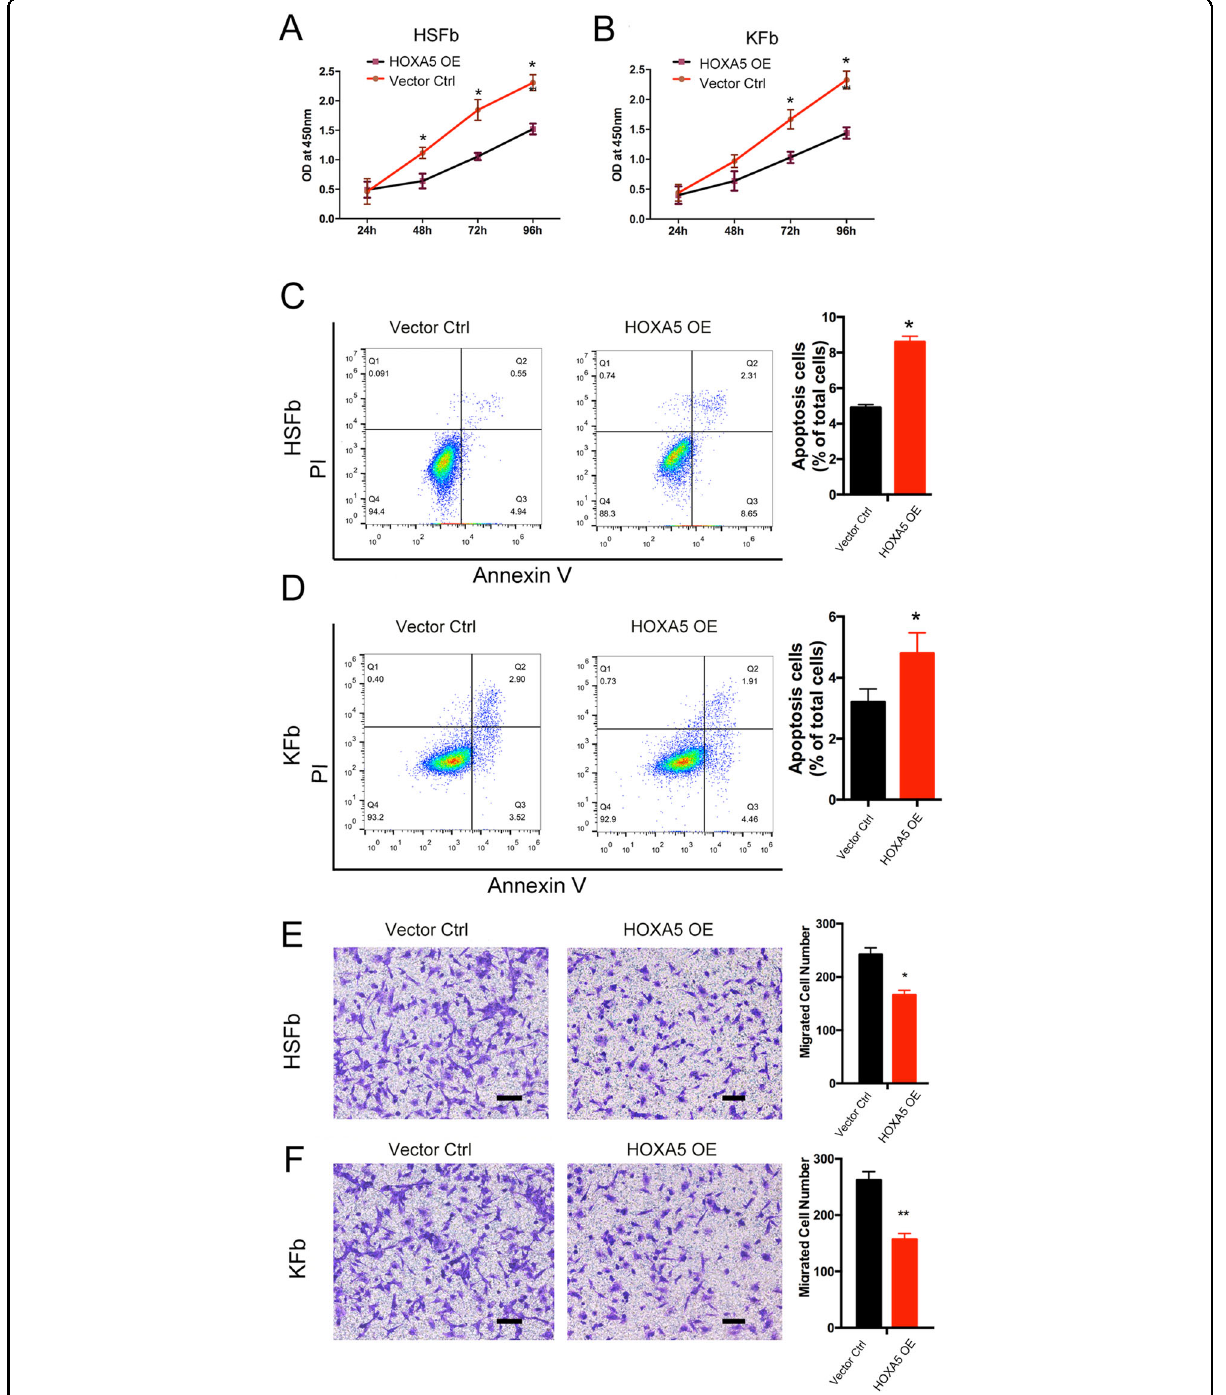
Fig. 1 Effects of HOXA5 overexpression on pathological scar-derived fi broblasts. A , B A CCK-8 assay was performed to determine the cell proliferation rates of fi broblasts derived from keloids (KFb) or from hypertrophic scars (HSFb) with/without HOXA5 overexpression. C , D Flow cytometric analysis was performed to determine the percentages of apoptotic KFb and HSFb in each group. E , F Transwell analysis was performed to determine the cell migration ability of KFb and HSFb in each group. * p < 0.05, ** p < 0.01. scale bar = 100 μ